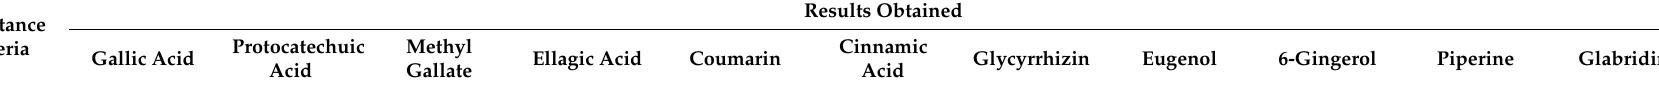
Table 3. Validation parameters for marker components in Divya-Swasari-Vati (DSV) (batch #B SWV117) using HPLC–DAD